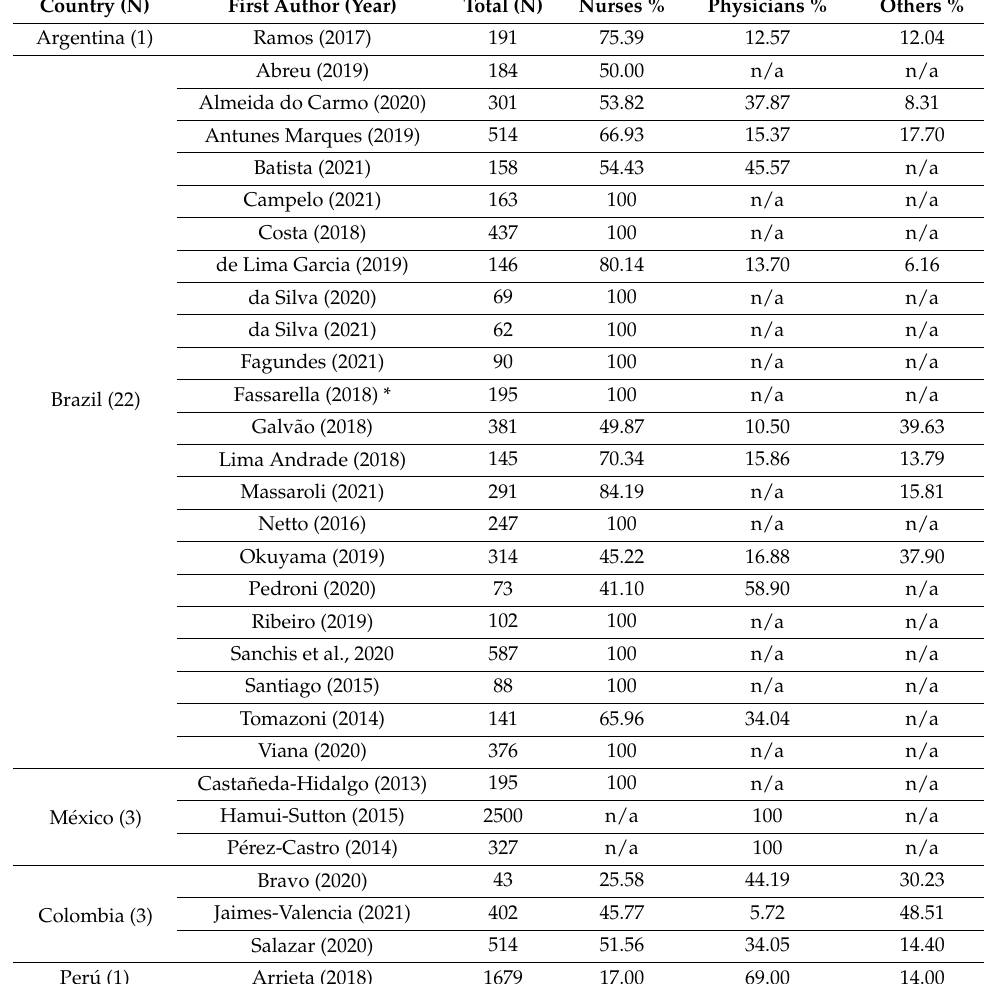
Table 1. Characteristics of the reviewed studies (n =